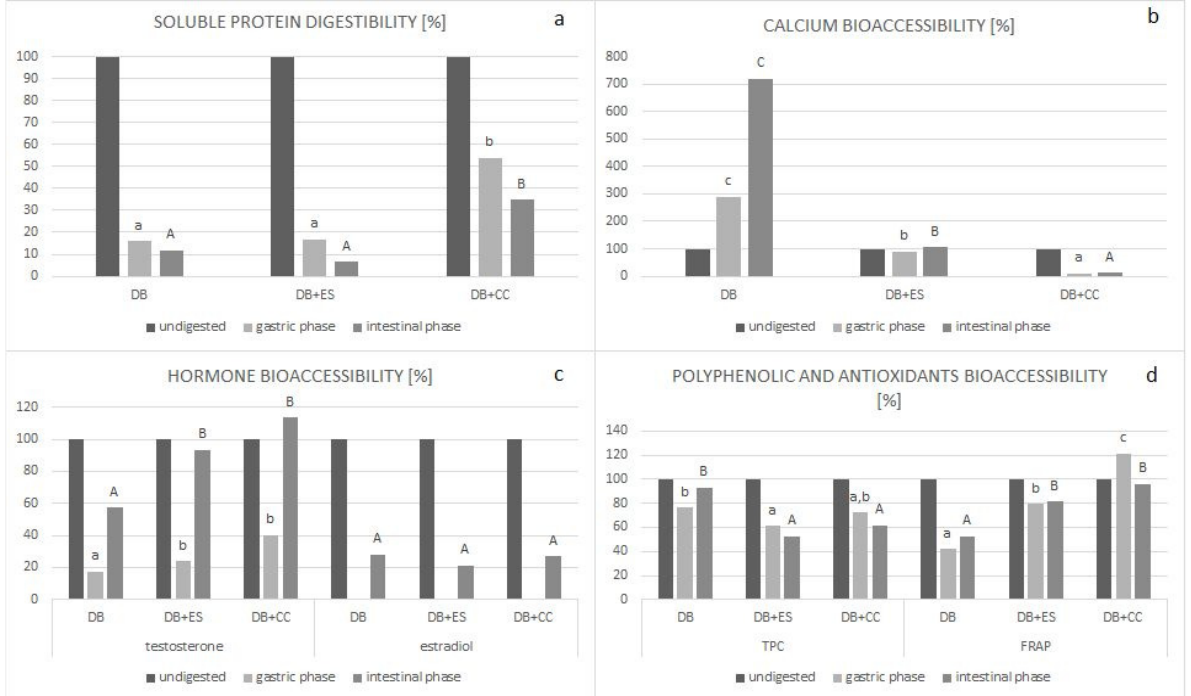
Figure 2. Digestibility index [%] of ( a ) proteins, and bioaccessibility index [%] of ( b ) calcium, ( c ) hormones, ( d ) polyphenols, and the reducing power of the tested capsule fractions. a,b,c —the results marked with different letters differ statistically significantly between the gastric fractions of the supplements ( p < 0.05); A,B,C —the results marked with different letters differ statistically significantly between the intestinal fractions of the supplements ( p <